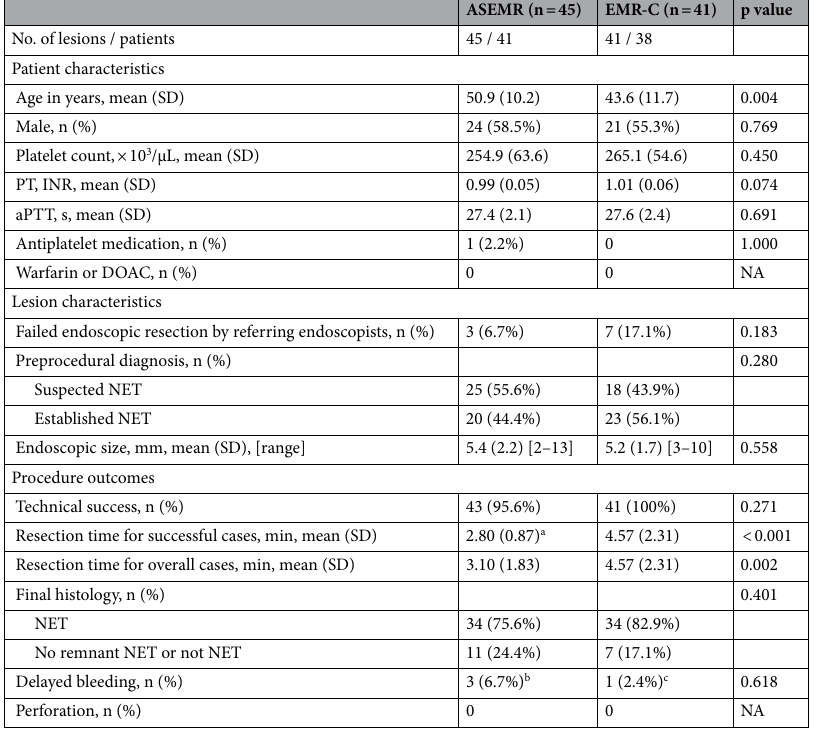
Table 1. Comparison of ASEMR (n = 45) versus EMR-C (n = 41) for suspected or established rectal NETs. ASEMR anchored snare-tip endoscopic mucosal resection, EMR-C cap-assisted endoscopic mucosal resection, NET neuroendocrine tumor, SD standard deviation, PT prothrombin time, INR international normalized ratio, aPTT activated partial thromboplastin time, DOAC direct oral anticoagulant, NA not applicable. a Two failed ASEMR cases were excluded because of direct conversion to ESD during the procedures. b Three patients experienced delayed bleeding in ASEMR group. One patient with 6 mm-sized rectal NET failed ASEMR attempt due to slippage of snare, and ASEMR was immediately converted to ESD. The other two patients showed scar change and lymphoid polyp in the final histology results, respectively. c One patient with 3 mm-sized rectal NET experienced delayed